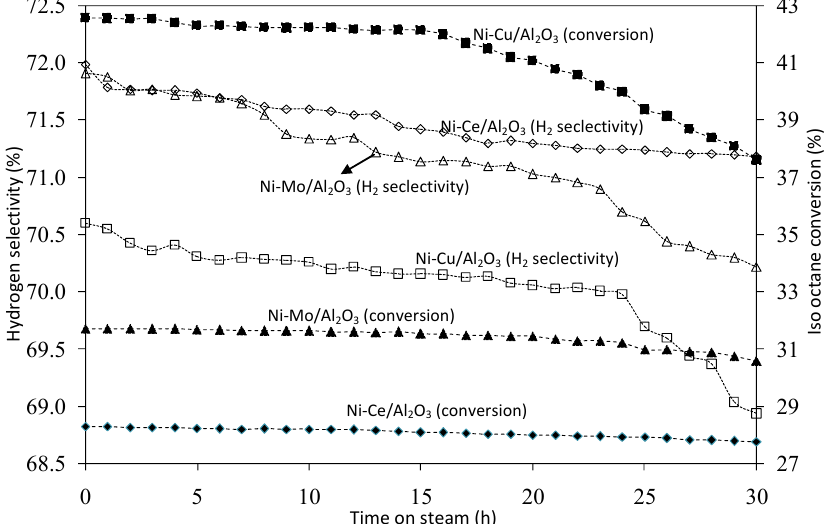
Figure 12. Durability testing of different catalysts in steam reforming for 30 h, T = 550 °C, N 2 = 15 cm 3 /min; iso ‐ octane feed rate was 0.03 g/min; S/C molar ratio: 0.9.